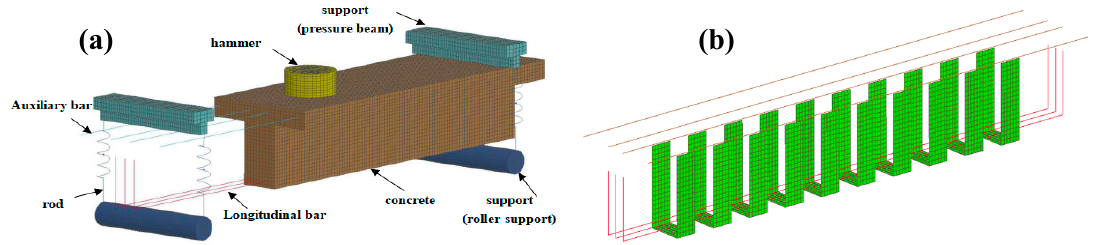
Figure 3. 3D finite element model of CFRP-strengthened T-beam. ( a ) Details of RC T-beam. ( b ) CFRP U-wraps.